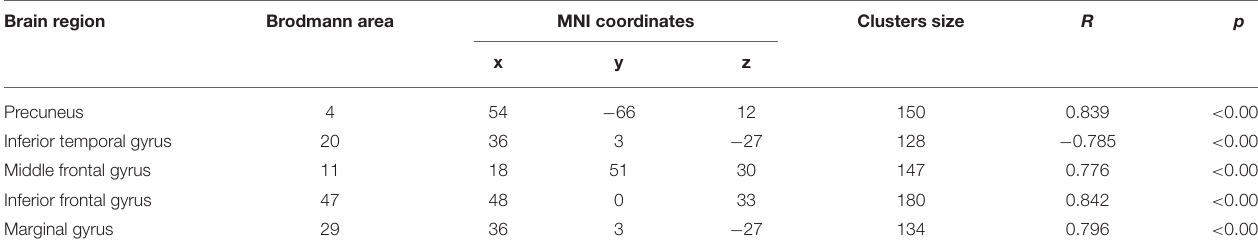
TABLE 5 | Significant differences in correlation between FC values and MoCA